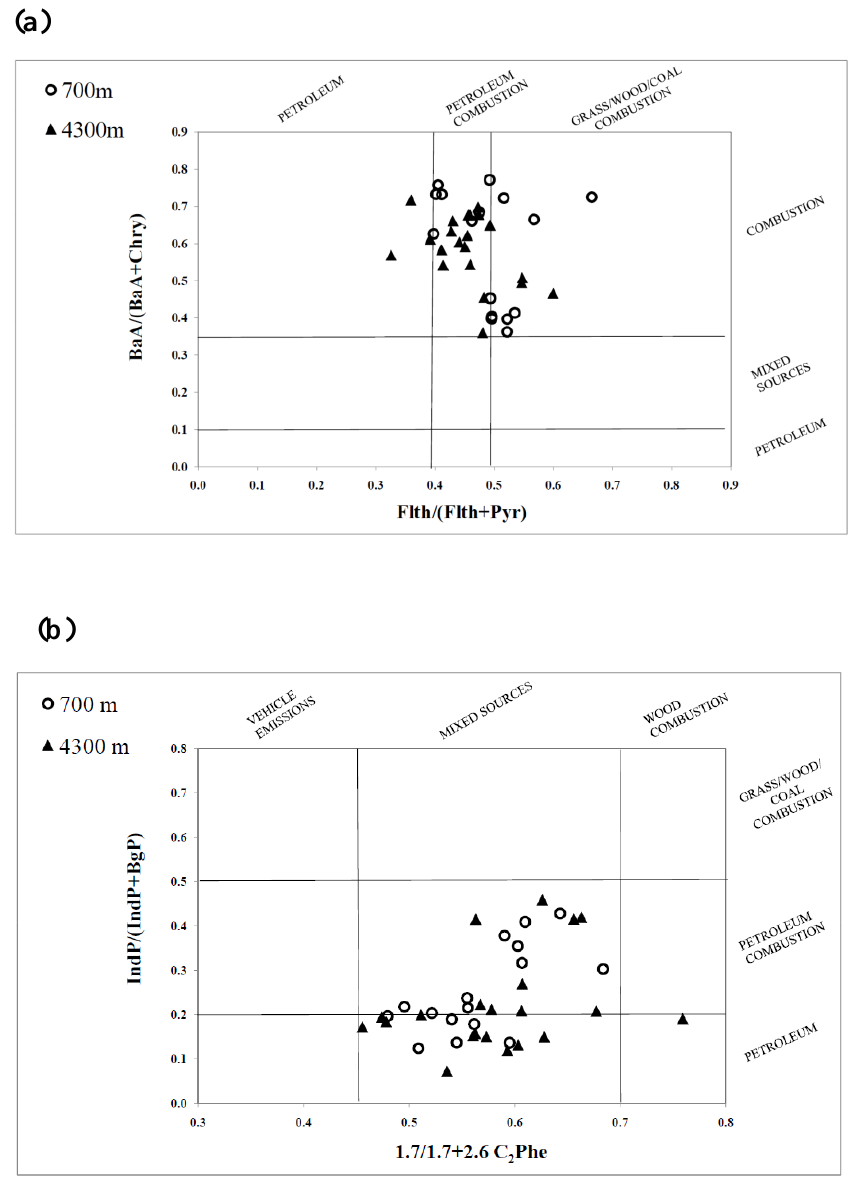
Figure 6. The BaA/(BaA + Chry) vs. Flth/(Flth + Pyr) ratio (a) and IndP/(IndP + BgP) vs. 1.7/(1.7 + Fig. 6. The BaA/(BaA + Chry) vs. Flth/(Flth + Pyr) (a) and IndP/(IndP + BgP) vs. 1.7/(1.7 + 2.6) C 2 -Phe (b) PAHs diagnostic ratios co-plots at 700m and 4300m depth, along with literature guidelines for specific sources (Yunker et al., 2002). 2.6) C -Phe ratio (b) PAH diagnostic ratios co-plots at 700m and 4300m depth, along with literature 2 guidelines for specific sources (Yunker et al., 2002). intercorrelated, it suggests a common transport mechanism in the deep layers of the Ionian Sea (Nestor site). This point is discussed in detail below in Sect.